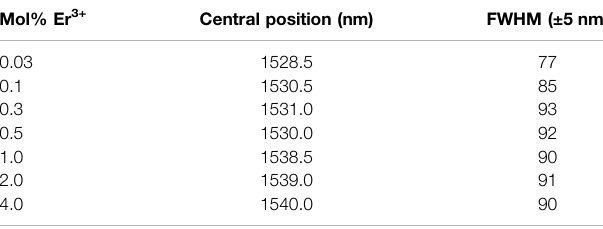
TABLE 5 | 4 I 13/2 emitting level lifetimes of Er 3+ -doped SiO 2 -Ta 2 O 5 planar waveguides for different Er 3+ concentrations.